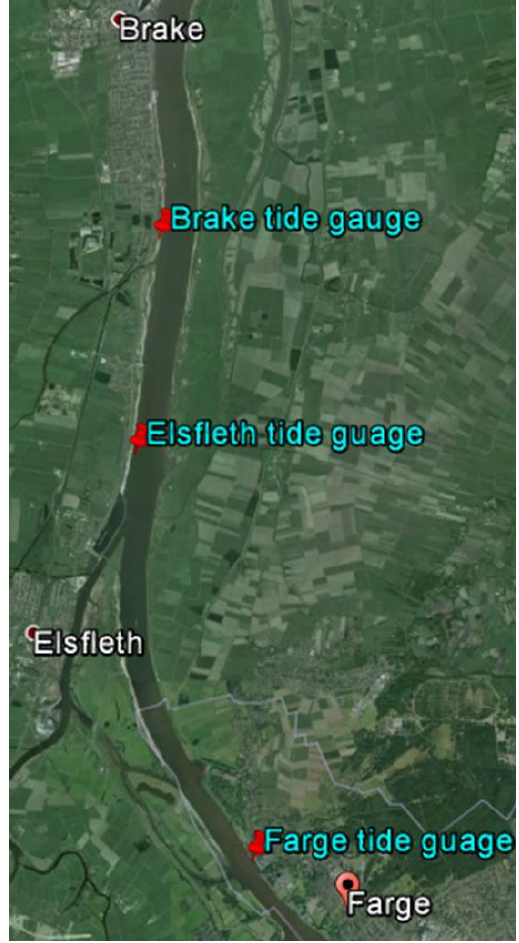
Figure 2: Illustration of the river segment under investigation (Google Earth). Red markers indicate the location of the three tide gauges along this river segment. The river flows from Farge in the south to Brake in the north.